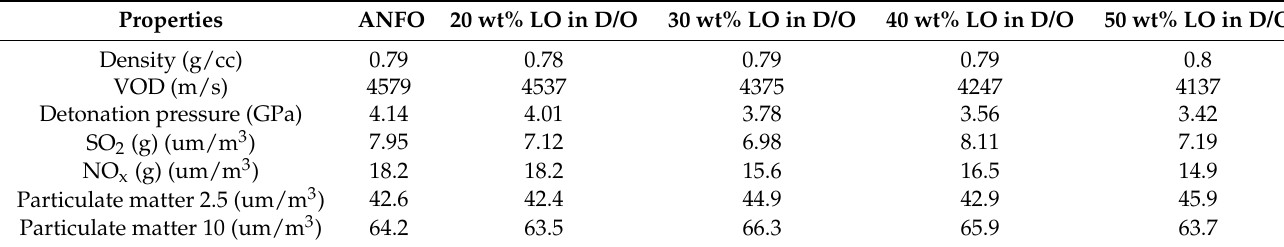
Table 10. Properties of ANFO explosives based on lubricating oil. Reprinted with permission of John Wiley and Sons from